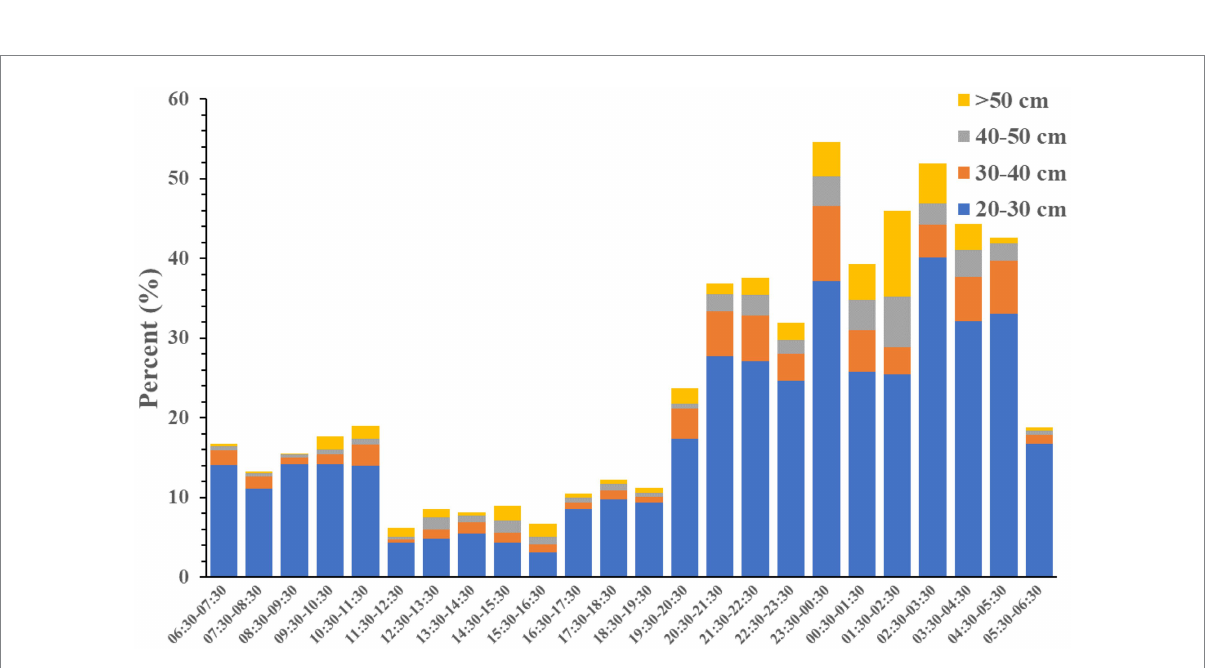
FIGURE 8 The temporal distribution of the percent contribution of the number of different body length group to the total number of fish in a full